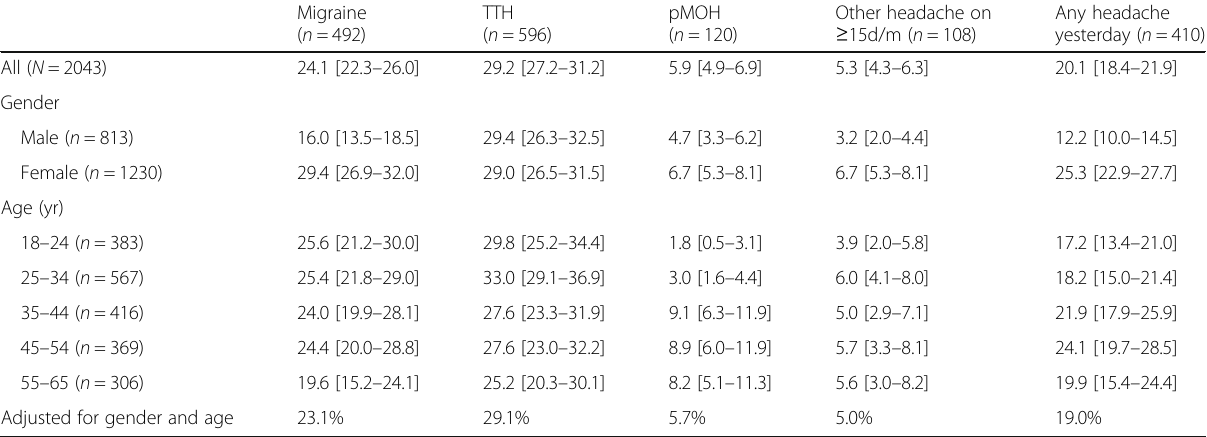
Table 2 Observed 1-year prevalence (% [95% confidence intervals]) by gender and age, overall and by headache type, and adjusted values for gender and age